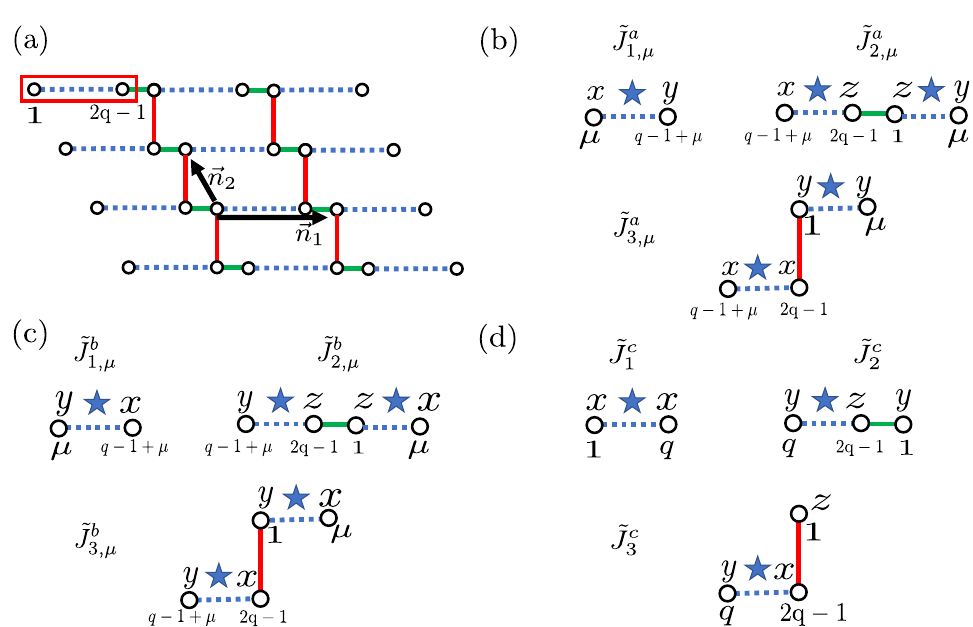
⃗ n + l ⃗ n ( l , l 1 1 2 2 1 2